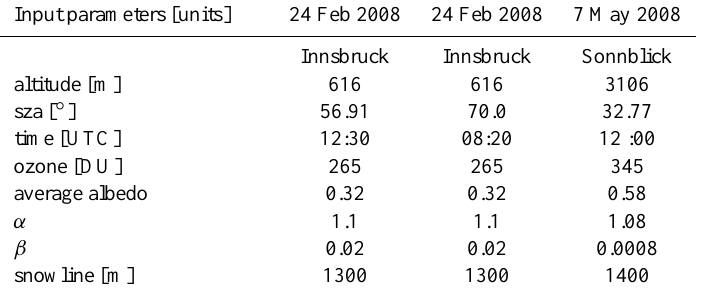
Table 1. Input parameters for model calculations (altitude in [m], solar zenith angle (sza) in [ ◦ ], time [UTC], total ozone column (ozone) in [DU], albedo, Angstrøm exponent and coefficient ( α and β ) and height of (snowline) in [m]. Simulations were performed for clear sky conditions.